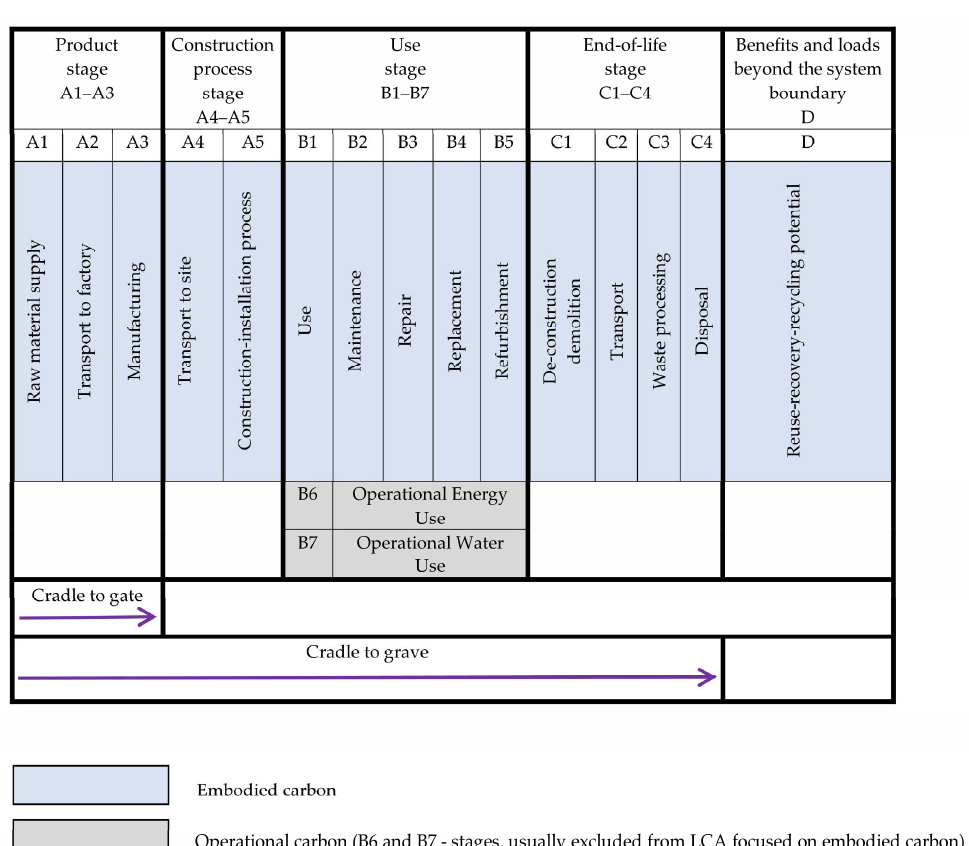
Figure 4. Life cycle stages and boundaries for construction products and works, adapted from [62,63].